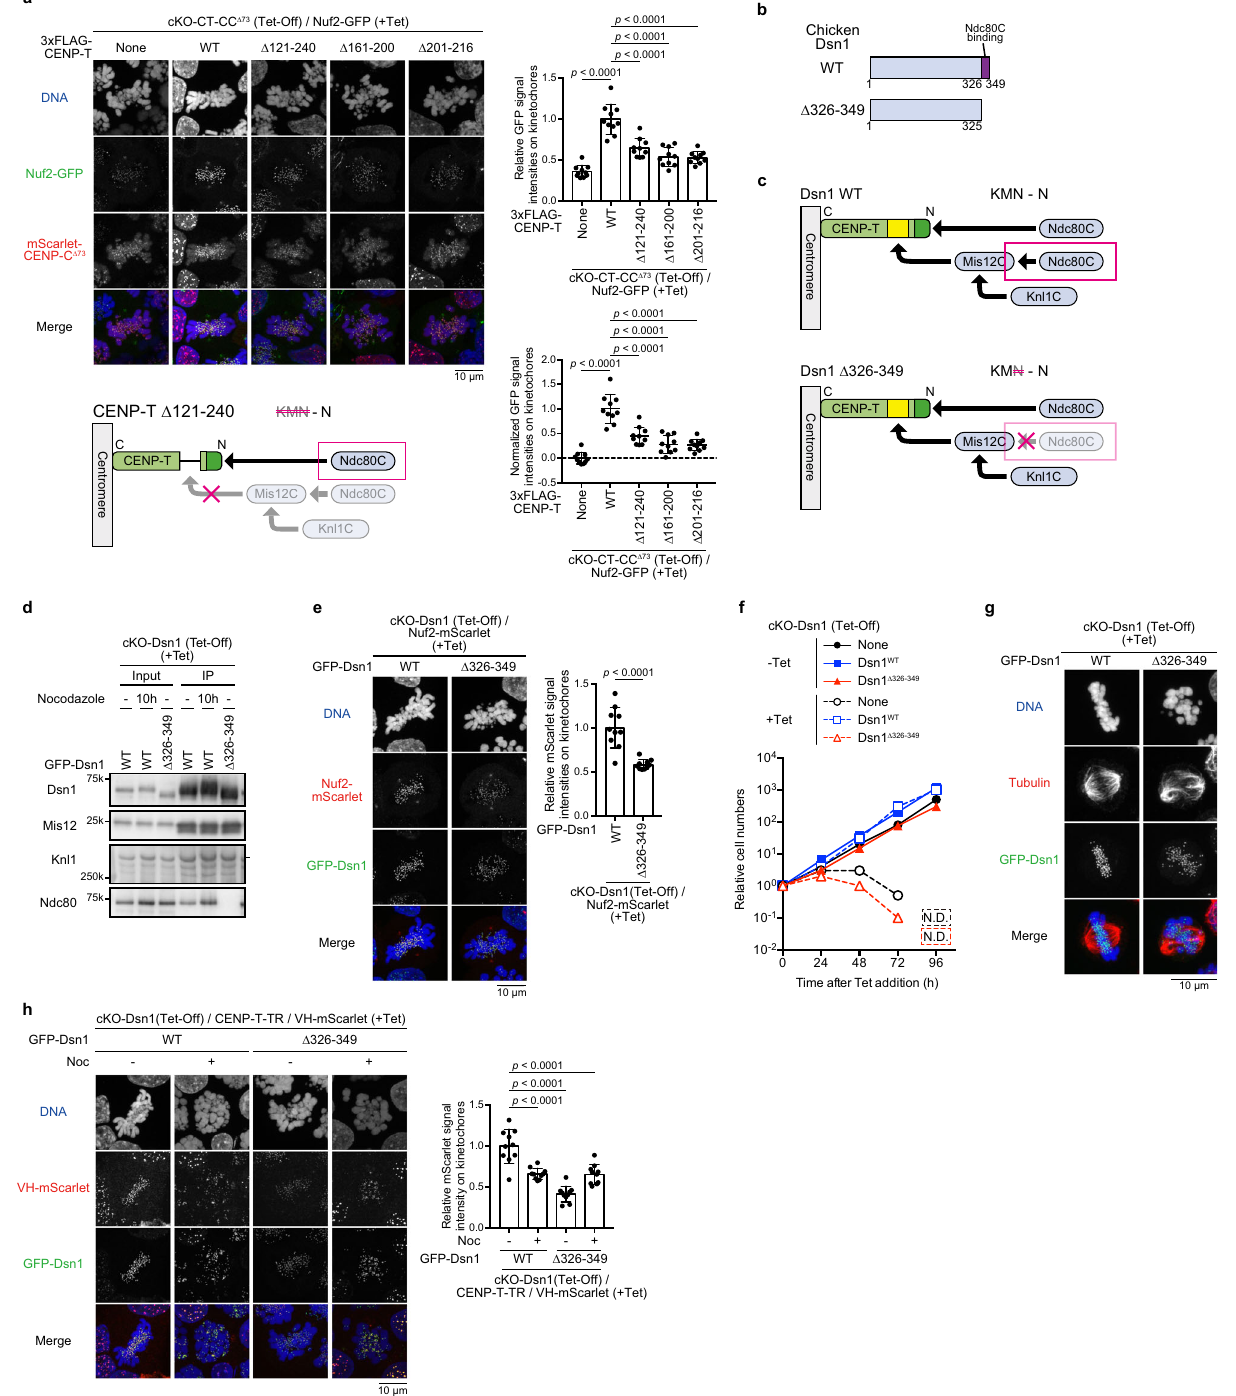
N-terminal region of CENP-T Δ 121-240 (Fig. 4a), which is con- sistent with our previous observation 35 .